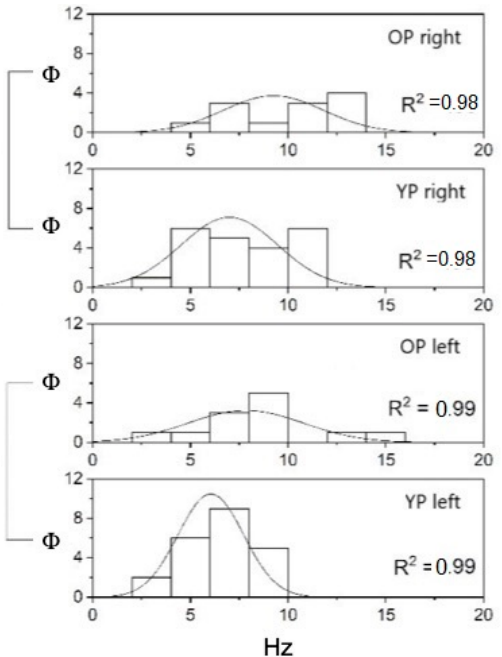
Figure 1. FN (Hz) in older and younger patients with SVINT applied on the right and left sides ( Φ = data distribution frequency). The Gaussian peak represents the mean of SVIN frequency in Hz. Normal curve vibrational FN distribution and fitting analysis, R 2 = 0.99 for both left YP and OP while R 2 = 0.98 for right YP and OP ( p < 0.001).